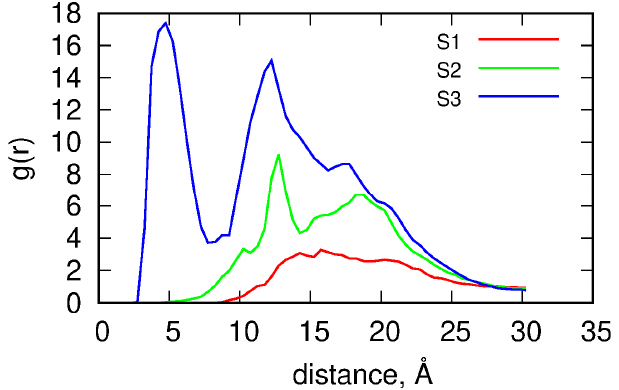
Figure 7. Radial distribution functions determined for the dendrimer–drug molecule distances.